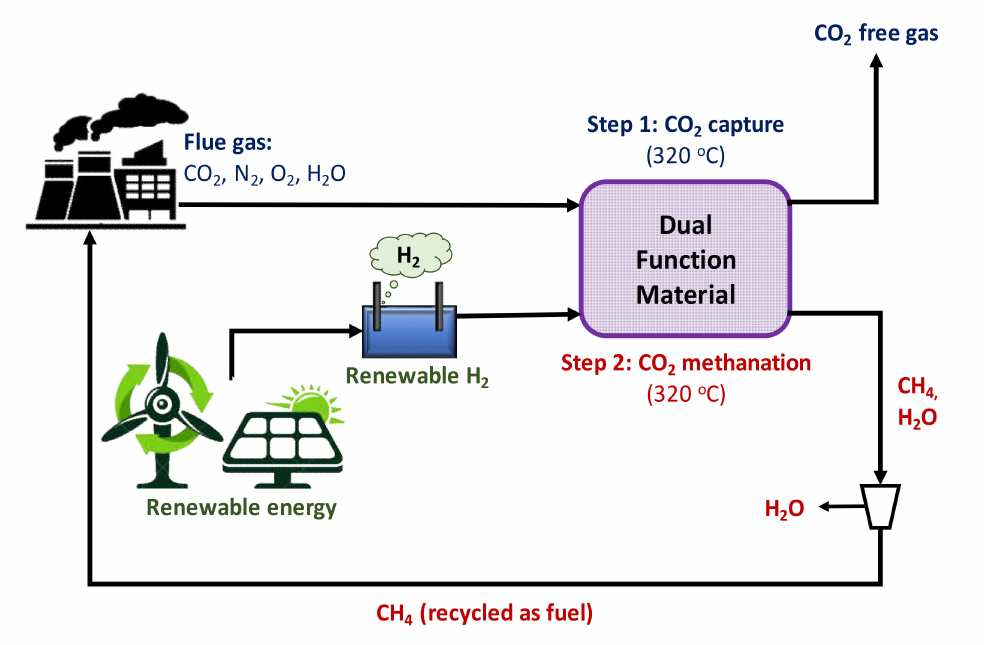
Figure 8. Schematic summarizing the dual-function materials (DFM) concept (adopted from [113]). Due to its easy reduction once oxidized, ruthenium’s role is crucial for isothermal DFM applications and it can provide stable performance [22]. From a kinetic point of view, Ru-based DFMs (5% Ru) appearred to achieve faster hydrogenation rates, even compared to their Rh-based analogues (0.5% Rh), when Na 2 CO 3 (or “Na 2 O”) was used as sorbent. Thus, Ru can be considered a superior